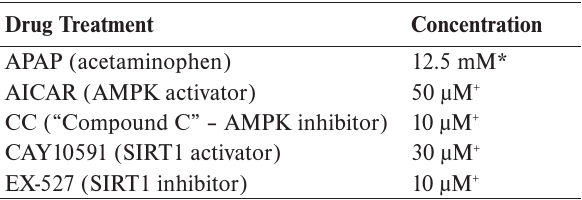
Table 1. Concentration of drugs used in primary rat hepato- cyte cultures. Drug Treatment